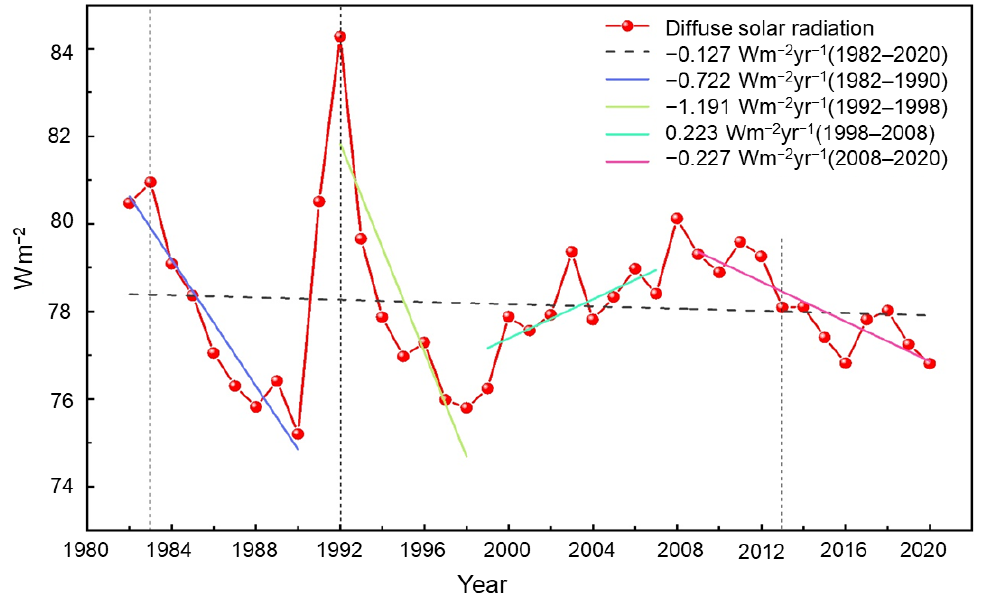
Figure 11. Interannual variation trend of diffuse solar radiation in China, 1982–2020.